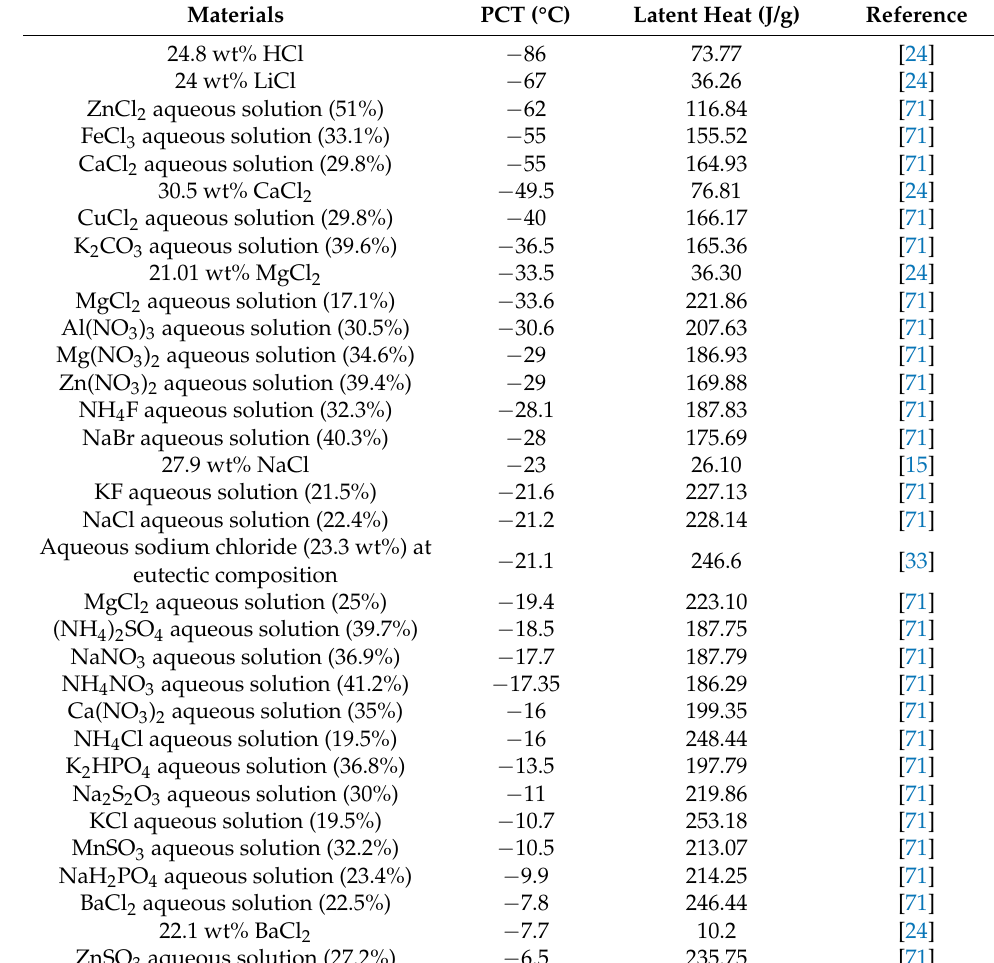
Table 4. Typical inorganic salt solution and eutectic PCMs for